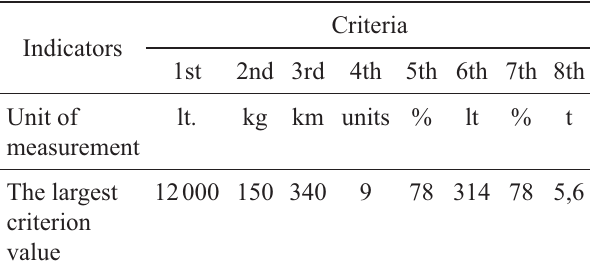
Table 4. The largest possible values of the criteria Indicators